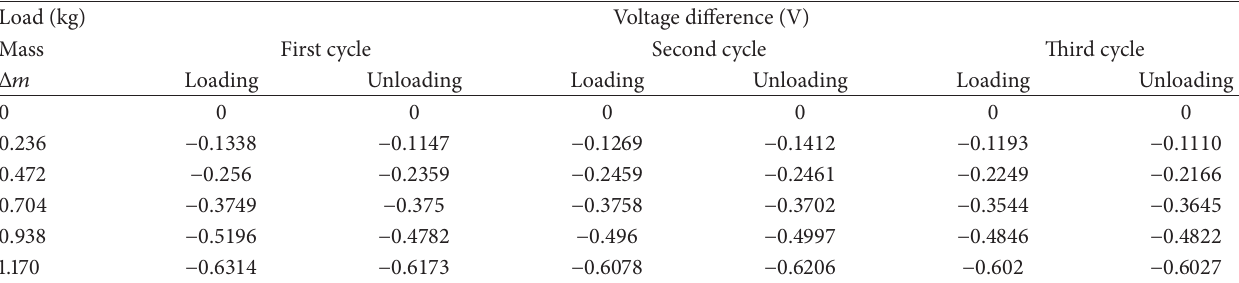
Table 2: Relation of variation Δ𝑚 and variation Δ𝑈 .